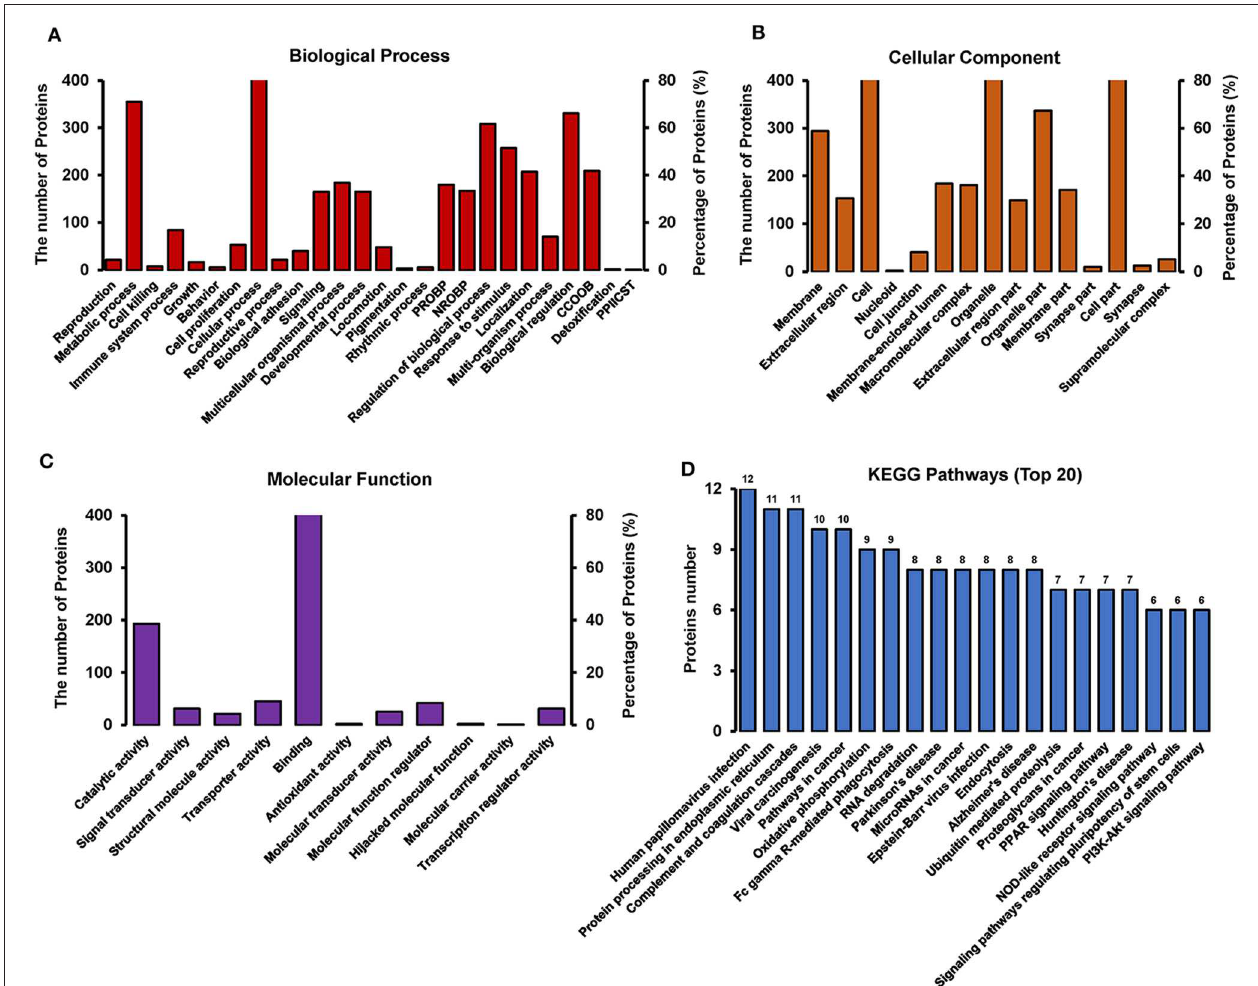
FIGURE 6 | GO and KEGG pathway analysis of differentially expressed proteins between TC0668 wt and TC0668 mut strains at 18h p.i ( P < 0.05). (A) Biological process. The items “PROBP,” “NROBP,” “CCOOB,” and “PPIICST” are the abbreviations of “positive regulation of biological process,” “negative regulation of biological process,” “cellular component organization or biogenesis,” and “presynaptic procell involved in chemical synaptic transmission,” respectively. (B) Cellular component. The item “cell” including all related cell components besides the parallel cell part, membrane, nucleoid and so on. (C) Molecular function. (D) KEGG pathway